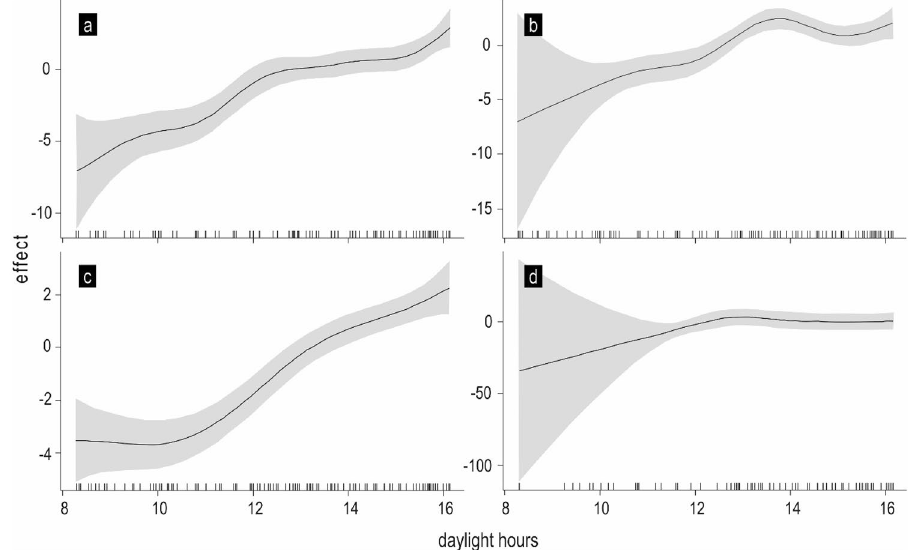
Figure 3. Effect of photoperiod on the probability of A. brama ( a ), L. idus ( b ), S. cephalus ( c ) and L. aspius ( d ) occurrence in the tributary. The solid line is an estimate of s daylength ; the shaded region shows (pointwise constructed) 95% confidence intervals for a given photoperiod.